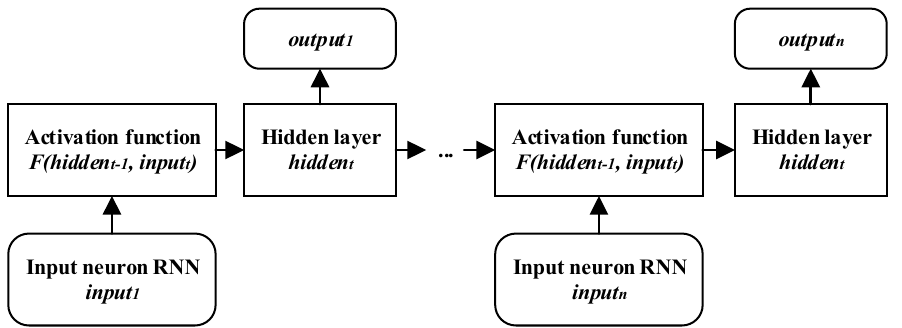
Figure 1. Schematic diagram of signal propagation in a recurrent neural network (many to many type).